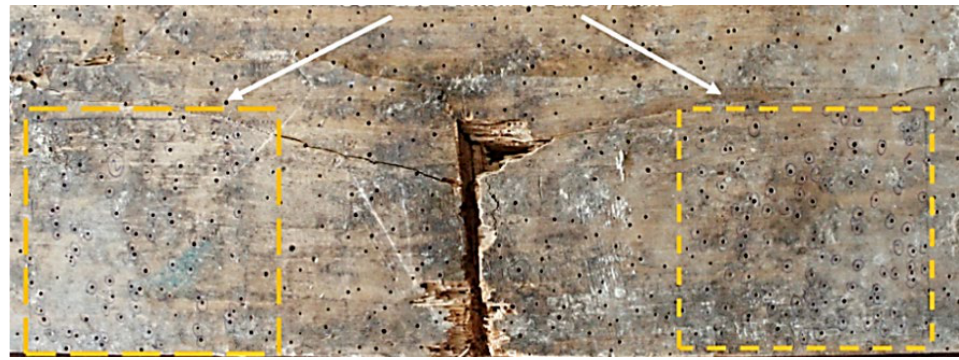
Figure 6. Marking and counting of flight holes per dm 2.